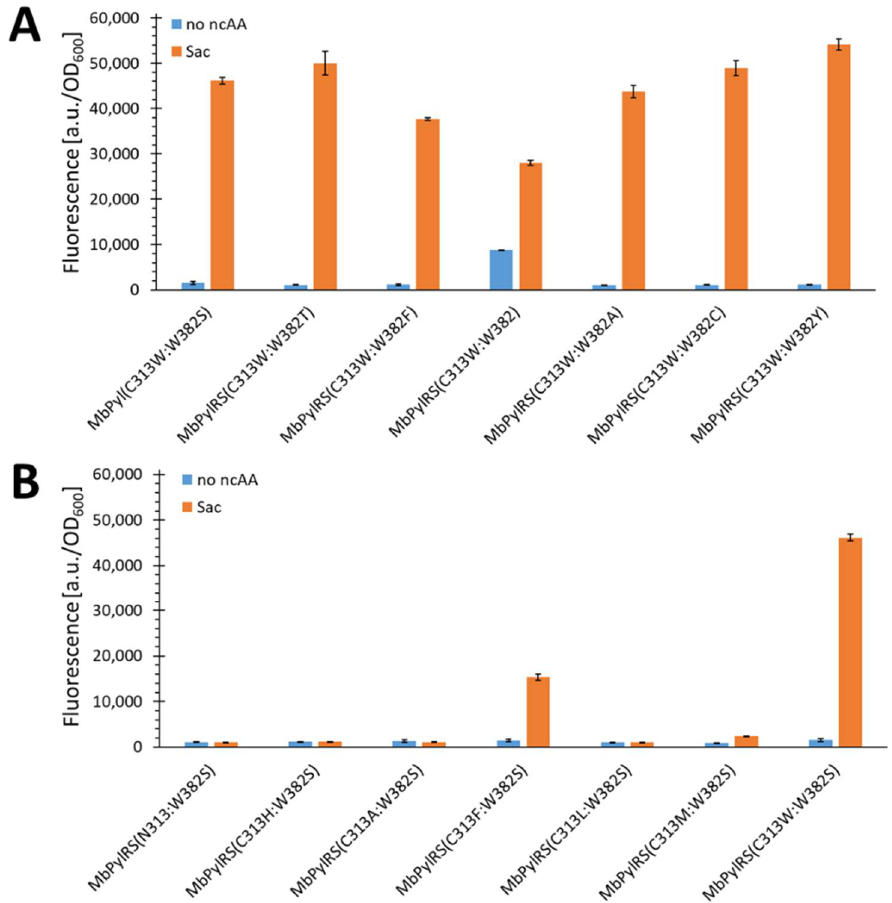
Figure 3. Comparison of Sac incorporation efficiency for Mb PylRS constructs ( A ) Mb PylRS(C313W) and variants mutated at position W382 and ( B ) Mb PylRS(W382S) with variants mutated at position C313. The fluorescence was measured for intact E. coli BL21(DE3) cells expressing the SUMO- sfGFP(R2amber) reporter protein. The data (incl. standard deviation) represent the mean of three biological replicates.